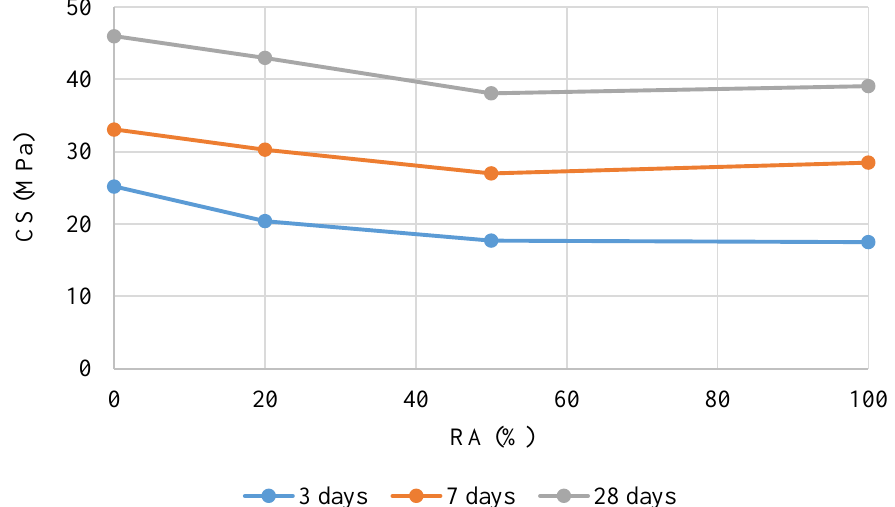
Figure 9. The CS of concrete with different amounts of